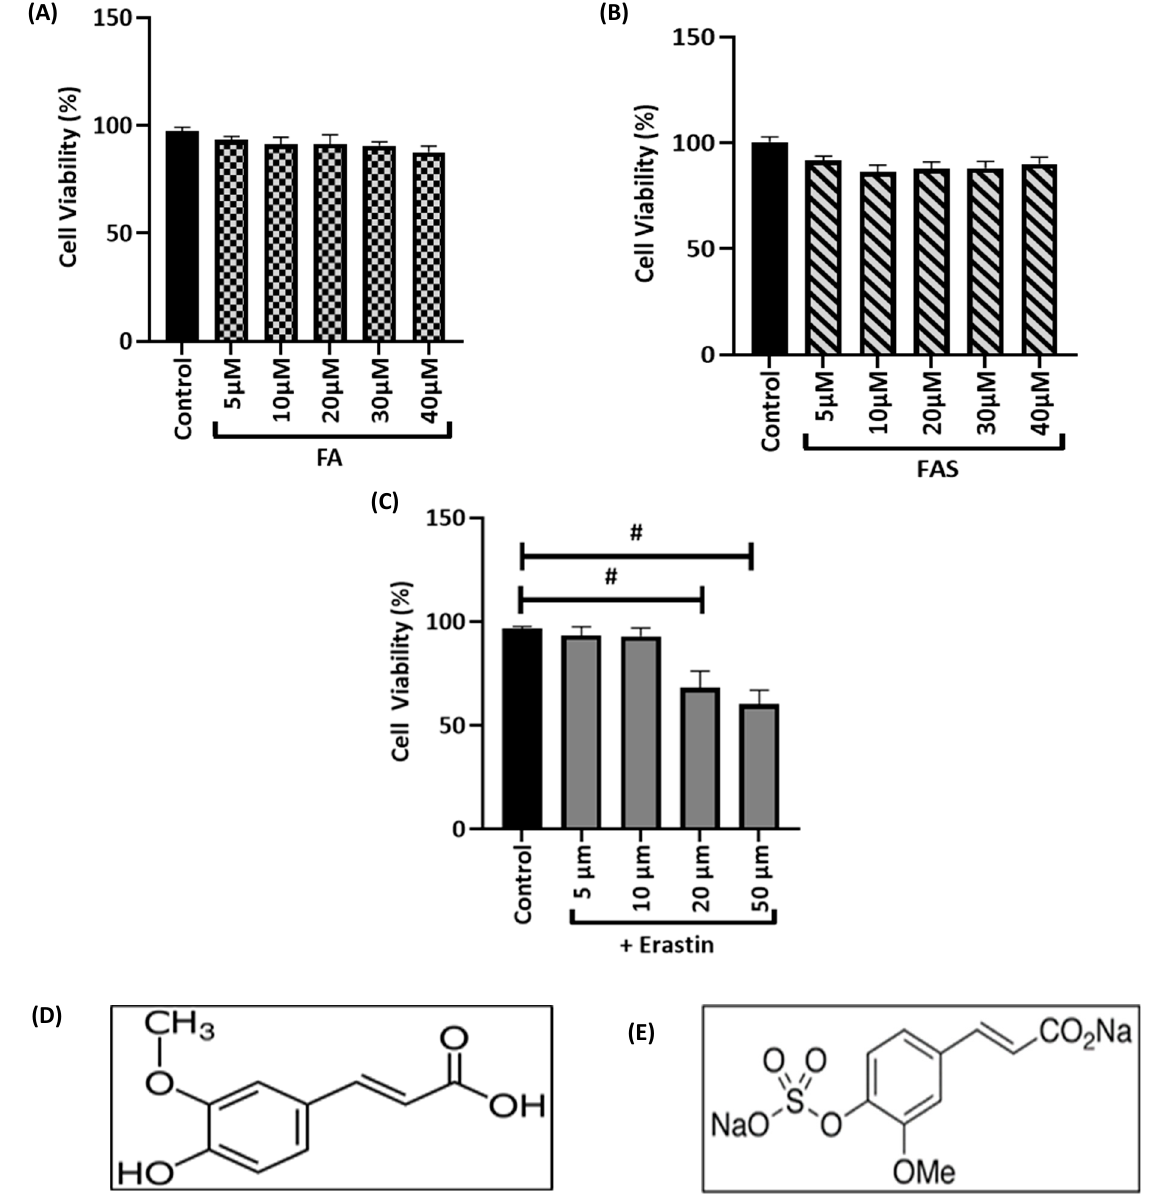
Figure 1. Relative cell viability of MIN6 cells against different concentrations of FA, FAS, or erastin. ( A ) MIN6 cells were exposed the different concentrations of ferulic acid (FA) for 24 h to determine its toxic concentration. ( B ) MIN6 cells were exposed to the different concentrations of ferulic acid 4-O-sulfate disodium salt (FAS) for 24 h to determine its toxic concentration. ( C ) MIN6 cells were treated with the indicated concentrations (5, 10, 20, and 50 μ M) of ferroptosis inducer, erastin, for 24. Cell viability was measured by MTT assay. Data are presented as the percentage of cell viability with the error bars representing the SEM. ( D ) Chemical structure of ferulic acid (FA). ( E ) Chemical structure of ferulic acid 4-O-sulfate disodium salt (FAS). All the values are expressed as the mean ± SEM, n = 8. # p < 0.05 control vs. treatment groups. One-way ANOVA, Tukey’s post hoc test.